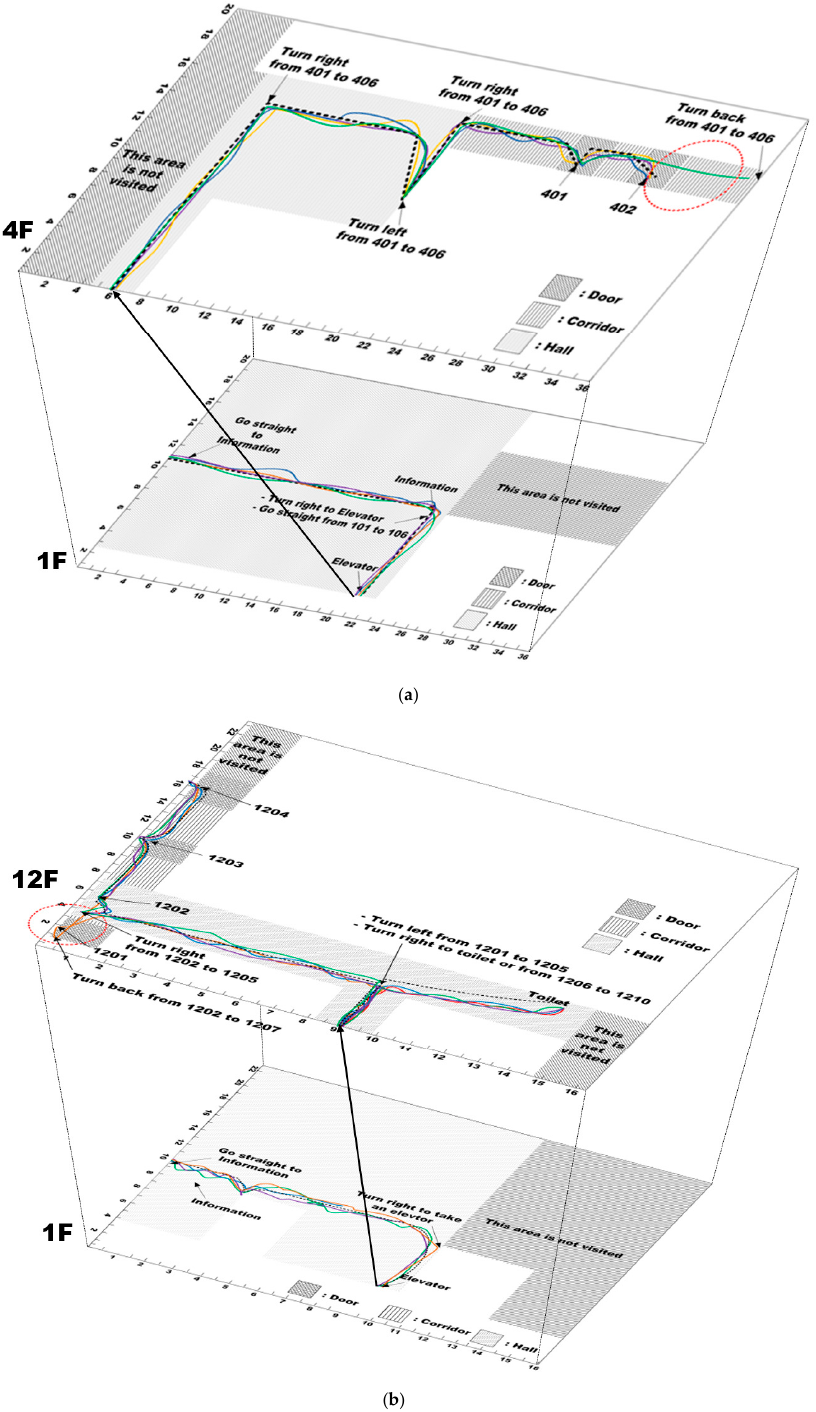
Figure 18. User trajectory results: ( a ) Environmental engineering building; ( b ) New millennium building. The black dotted line shows the optimal route, and the other color lines represent the traces of each user. The red circles indicate the positions where errors are occurred.